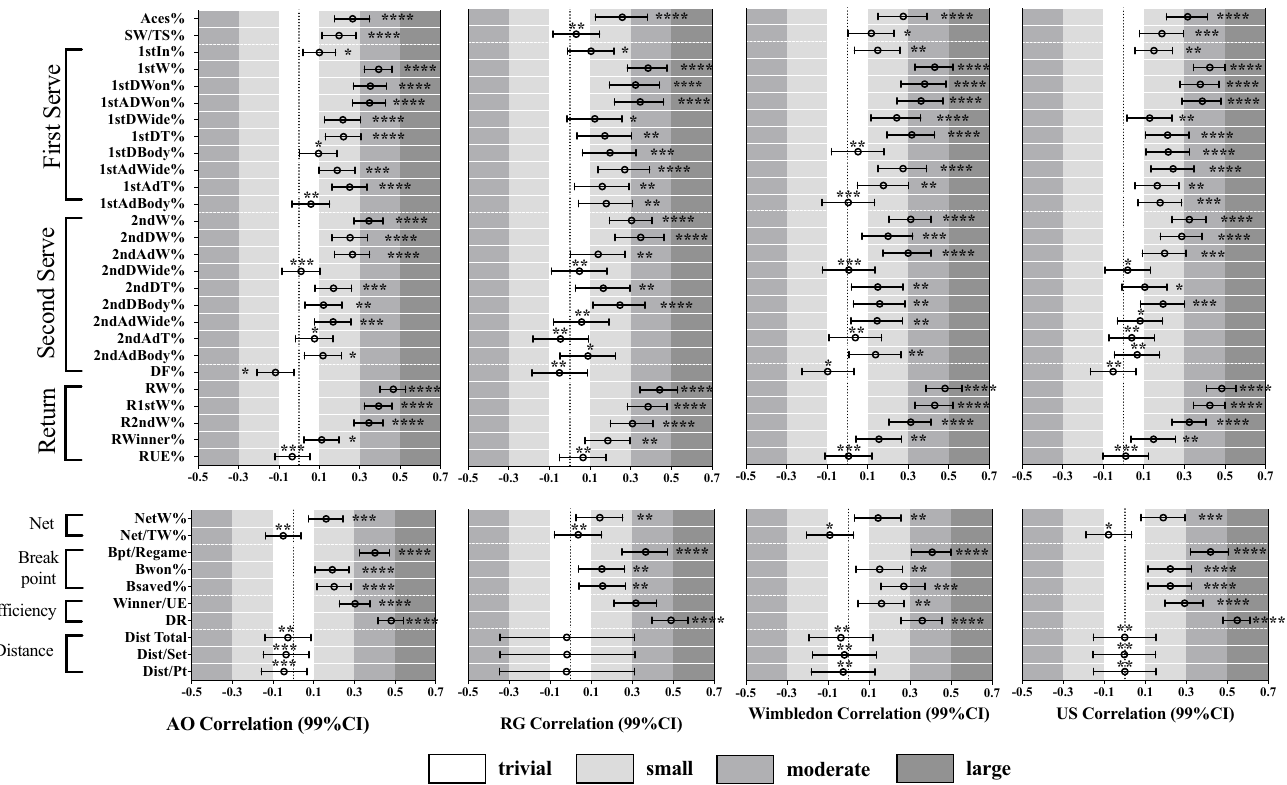
Fig 2. Relationships between match variables and the relative quality (RQ) for female players in four Grand Slams. Asterisks represent the likelihood for the magnitude of true correlation as follow: (cid:3) possible, (cid:3)(cid:3) likely, (cid:3)(cid:3)(cid:3) very likely, (cid:3)(cid:3)(cid:3)(cid:3) most likely. Asterisks located in the trivial zone denote for trivial correlation. Legends: Ace% = Aces of all serves%; SW/TW% = Service winners of all serves%; 1stIn% = First serve in%; 1stW% = First serve points won%; 1stDW% and 1stAdW% = First serve points won in deuce and advantage courts%; 1stDWide%, 1stDT% and1stDBody% = First serve points won in Wide, T and Body locations of the deuce court; 1stAdWide%, 1stAdT% and 1stAdBody% = First serve points won in Wide, T and Body locations of the advantage court; 2ndW% = second serve points won%; 2ndDW % and 2ndAdW% = Second serve points won in deuce and advantage courts%; 2ndDWide%, 2ndDT% and 2ndDBody% = second serve points won in Wide, T and Body locations of the deuce court; 2ndAdWide%, 2ndAdT% and 2nddBody% = second serve points won in Wide, T and Body locations of the advantage court; DF% = double faults of the second serves%; RW% = Total Return points won%; R1stW% and R2ndW% = Return first and second serves won%; Rwinner% and RUE% = Return winner and unforced error of total returns%; NetW% = Net points won%; NetW/TW% = New won of total points won%; Bpt/Regame = Break points per return game ratio; Bwon% = Break points won%; Bsaved% = Break points saved%; Winner/UE = Winner per unforced error ratio; DR = Dominance ratio; Dist. Total = Mean meters run per match; Dist/Set = Mean meters run per set; Dist/Pt = Mean meters run per point. Note: Abbreviations can be applied to the whole text.